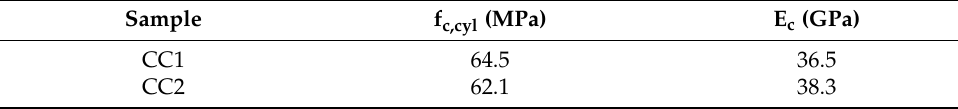
Figure 4. Preparation for material properties testing. Drilling ( a ); removed samples ( b ). Table 1. Materials properties of concrete.